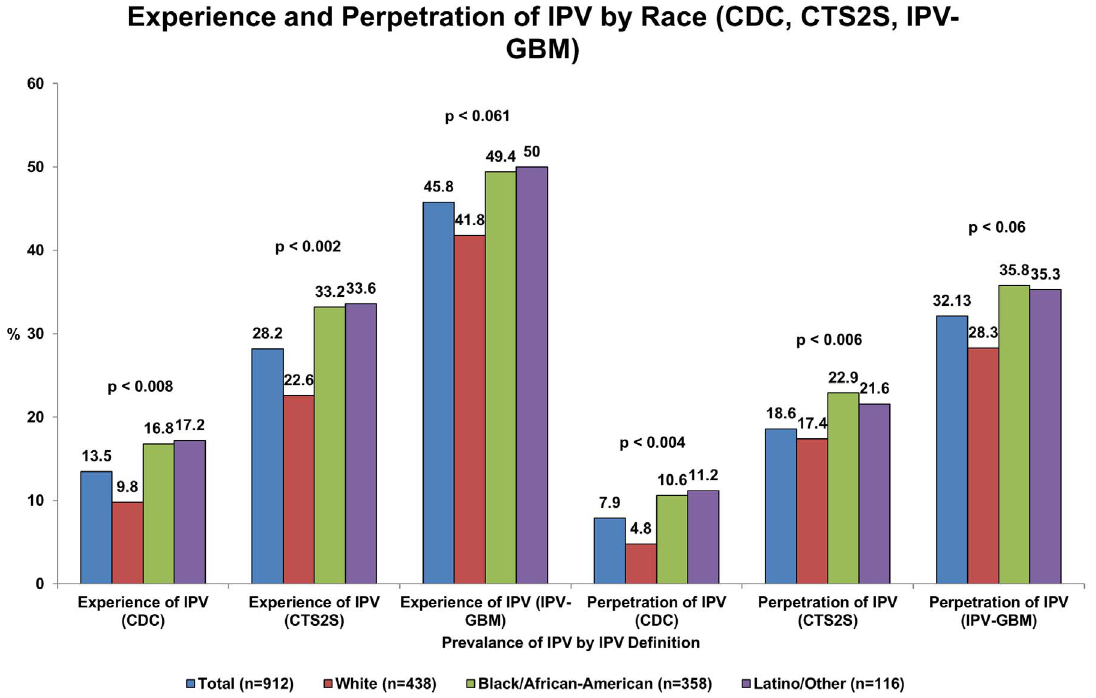
Figure 1. Receipt of IPV and Perpetration of IPV, in total and by race, as measured by the CTS2S, CDC, and IPV-GBM definitions of IPV, and chi-square p-values.